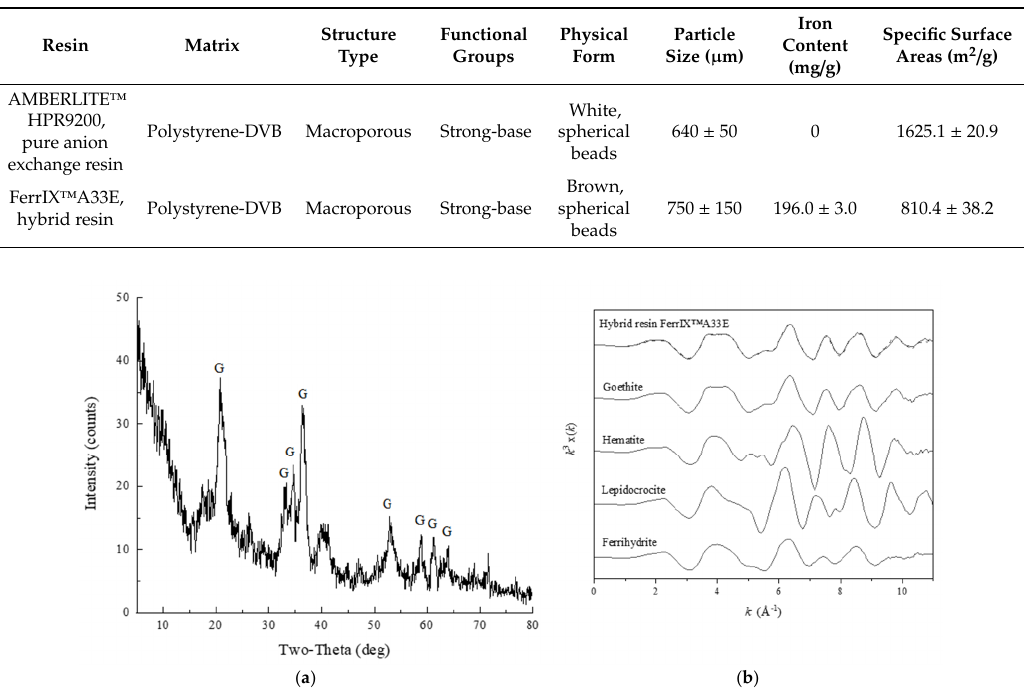
Figure 2. ( a ) XRD pattern of the ground hybrid resin FerrIX™A33E. Identified peaks correspond to goethite (G), and ( b ) linear combination fit of reference compound fit of a normalized k 3 weighted spectrum of the hybrid resin with spectra of reference minerals. Dotted line indicates fit. The fit results show the Fe oxide mineralogy of the hybrid resin is 100% goethite with r-factor of 0.01. The total surface area of FerrIX™A33E (i.e., hybrid HPR9200), 810.4 ± 38.2 m 2 /g, is significantly lower than that of HPR9200 (1625.1 ± 20.9 m 2 /g), which could be explained by the surface coverage of small goethite particles over the porous structure of pure anion exchange resin.